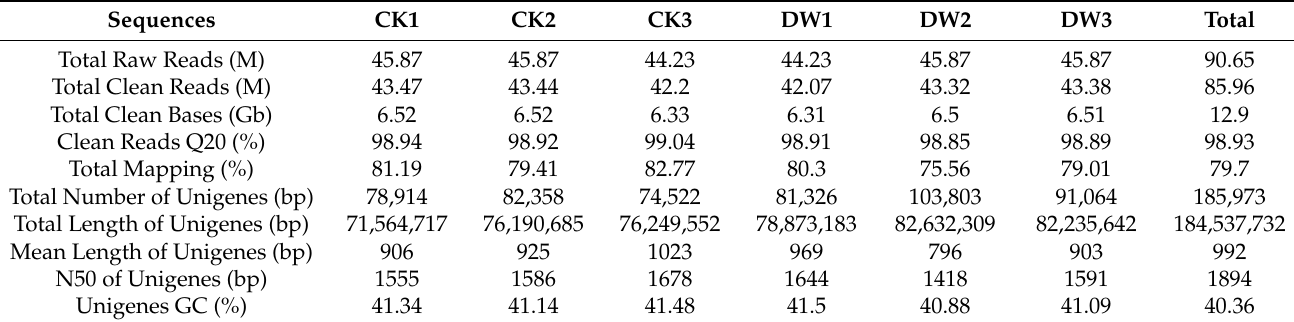
Table 2. Overview of Sequencing and Splicing Data.